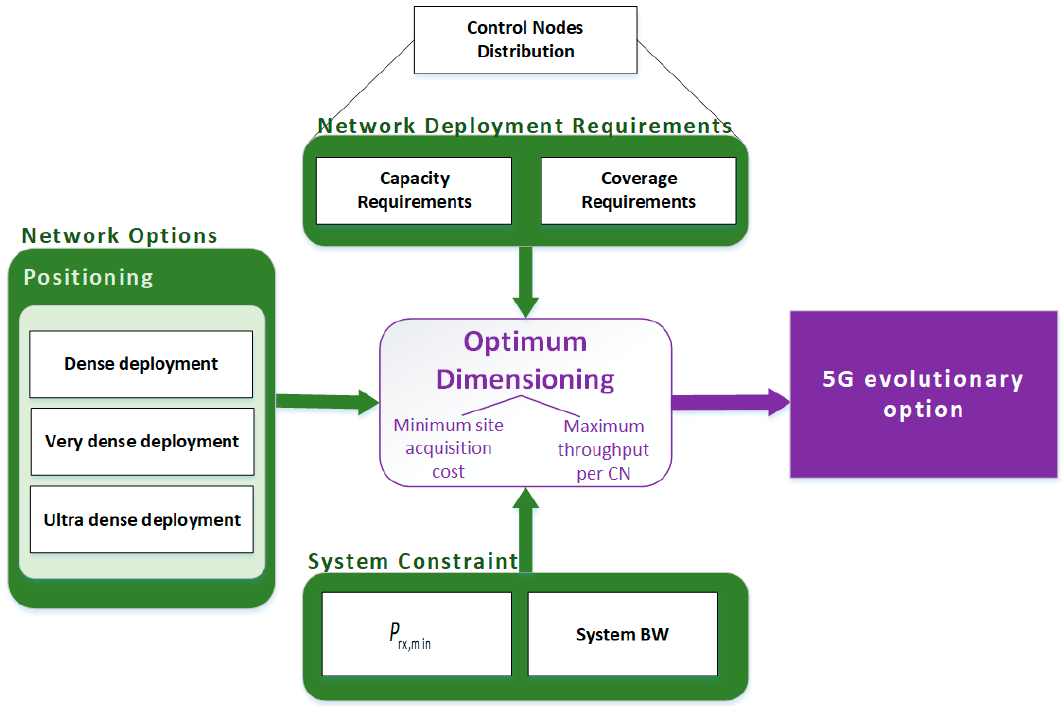
Figure 6. Radio network planning outline [74].